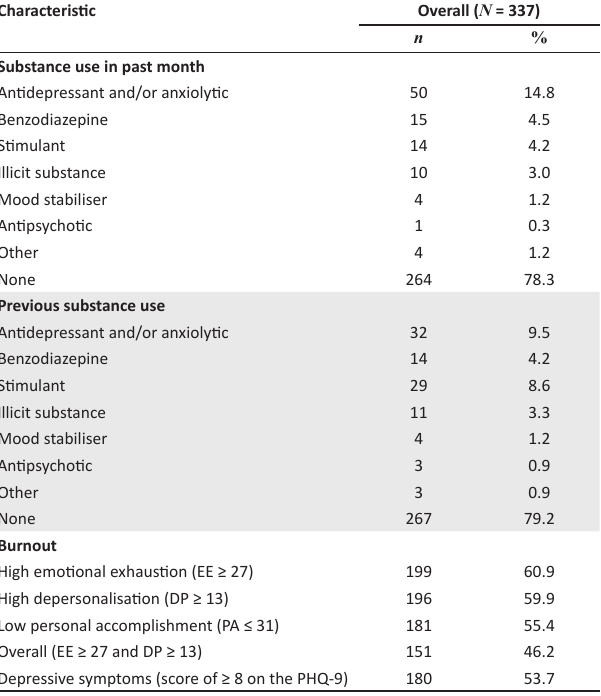
TABLE 2 (Continues...) : Characteristics of the study participants.